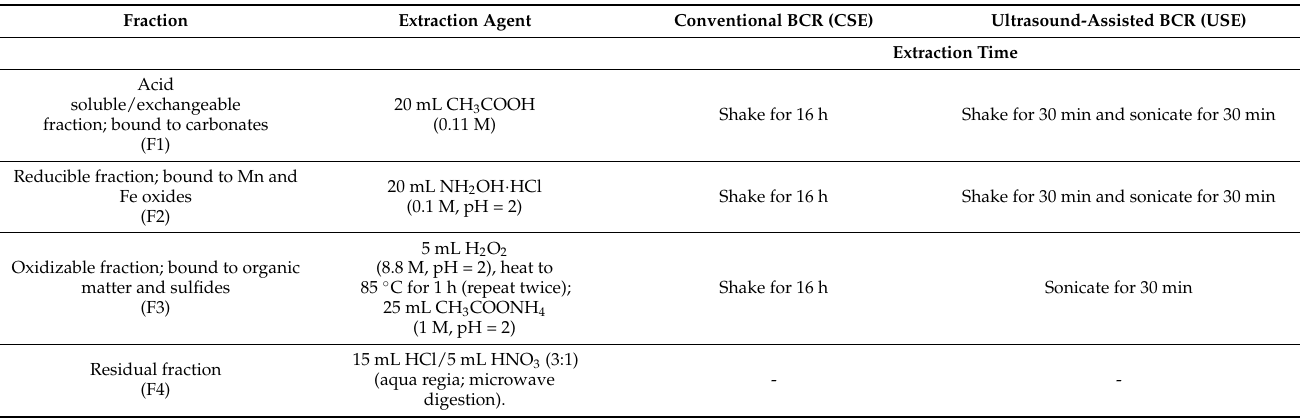
Table 3. A comparison of the conventional and ultrasound-assisted BCR sequential extraction methods [12,13] (this